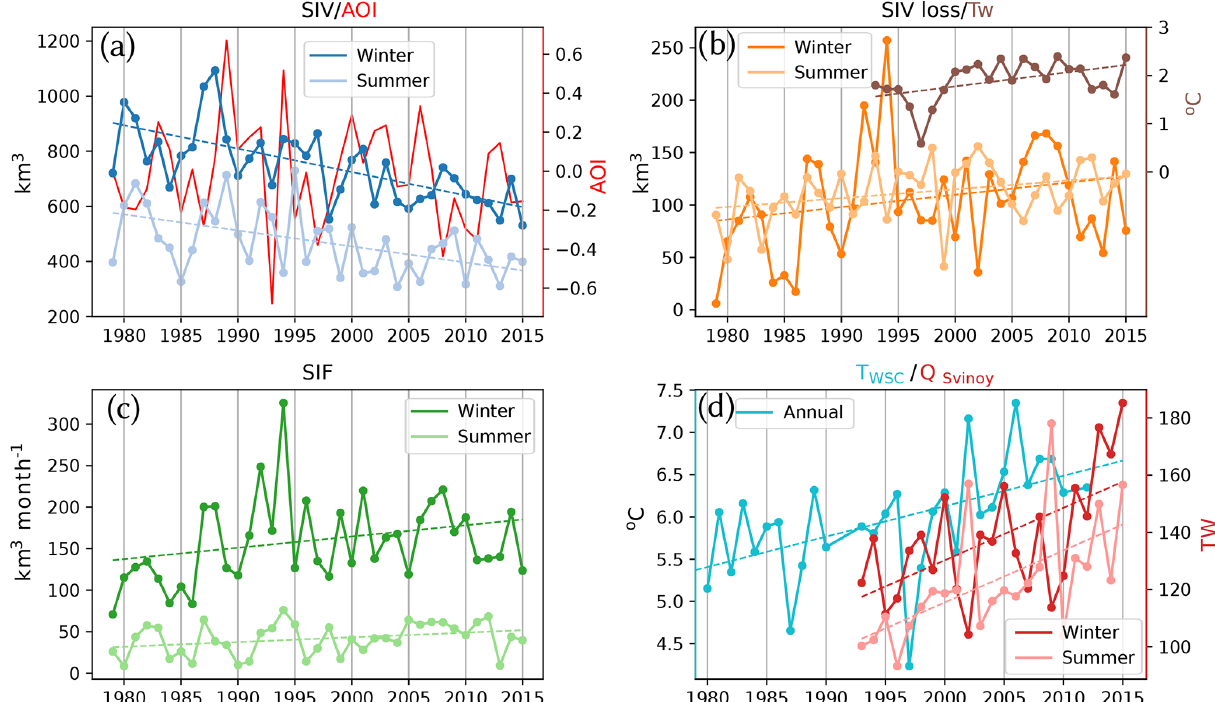
Figure 4. Time series of winter (December–April) and summer (May–November) and annual ice ocean atmosphere characteristics in the Greenland Sea: (a) monthly mean PIOMAS sea ice volume (SIV, km 3 ) and monthly summer AO index (AOI), (b) monthly mean PIOMAS sea ice volume loss (SIV loss, km 3 ) and mean September water temperature in MIZ ( T w, ◦ C), (c) monthly mean sea ice volume flux through Fram Strait (SIF, km 3 month − 1 ), and (d) annual mean water temperature in the West Spitsbergen Current ( T WSC , ◦ C) and monthly mean ocean heat flux ( Q Svinøy , TW) through Svinøy section (see Fig.